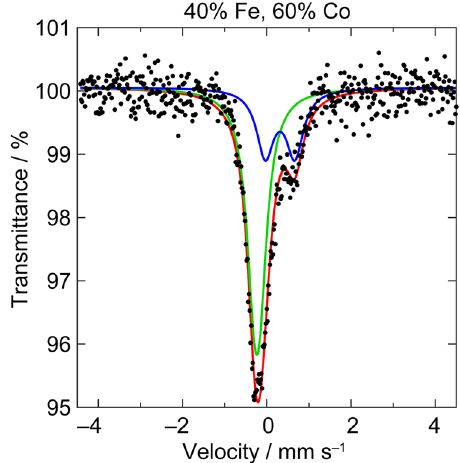
Fig. 1 Mössbauer spectra of CoFeO x . Zero- fi eld 57 Fe Mössbauer spectra for CoFeO x fi lms with the composition 40% Fe:60% Co. Raw data (black circle), fi t for Fe 3 + species (blue line), Fe 4 + species (green line), and overall fi t (red